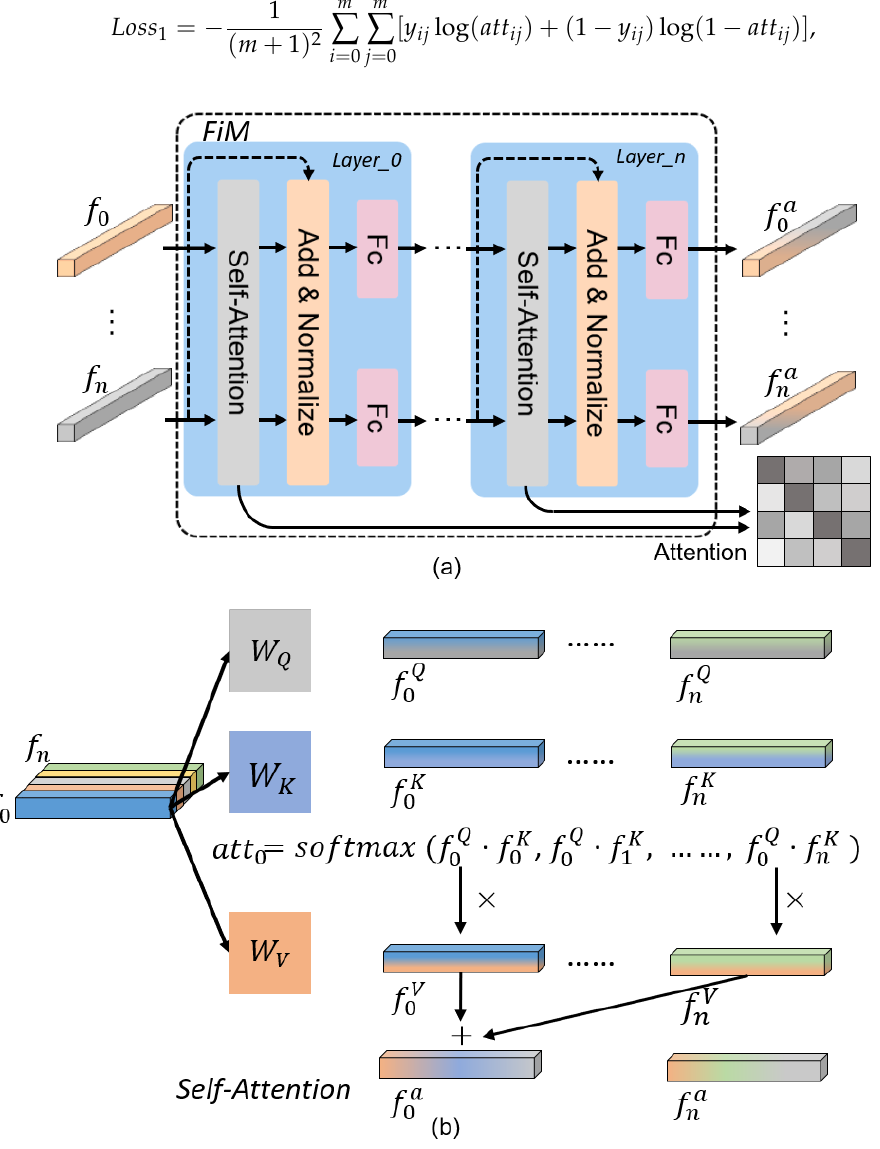
Figure 3. ( a ) The structure of the FiM module. The attention computed at each layer is extracted and used to screen the combinations of instances for which semantic relations actually exist. ( b ) The process of computing attention and fusing features for n + 1 instances in an